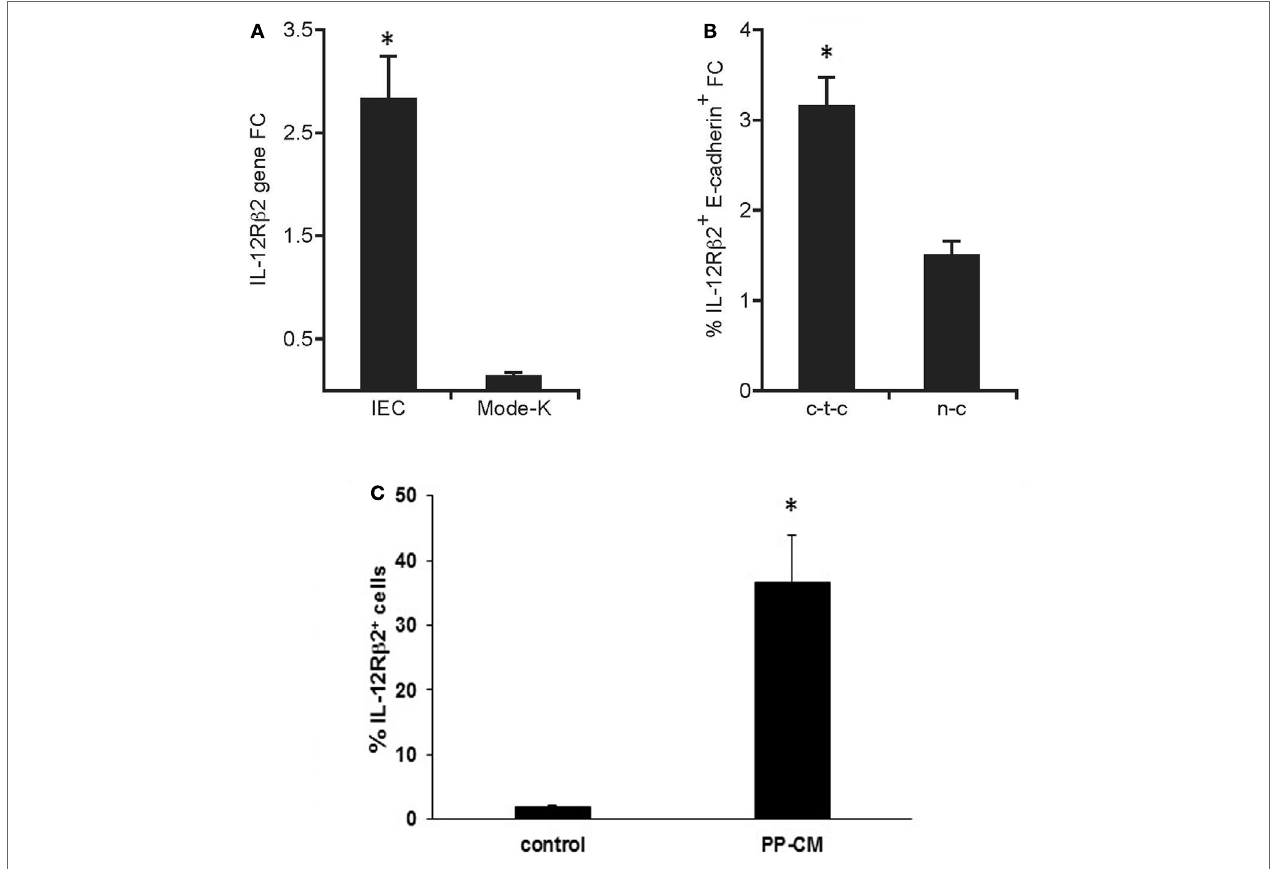
FigUre 3 | Immune system-derived signal(s) are required for the expression of functional IL-12R β 2 on intestinal epithelial cells (IECs). Quantitative RT-PCR analysis showed that the expression of IL-12R β 2 was significantly higher on freshly isolated primary IECs compared to cultured intestinal epithelial cell line MODE-K (a) . By contrast (B) , higher expression of IL-12R β 2 (1.5-fold chance, FC, increase compared IL12R β 2 expression levels in MODE-K untreated control cells) was seen when Peyer’s patch-derived lymphocytes were seeded in the bottom compartment of the Transwells culture system not in contact with MODE-K cells (n-c). However, a more pronounced increase (3.2-fold) was seen when PP-lymphocytes were allowed cell-to-cell interaction with the MODE-K cells (c-t-c). Expression of IL-12R β 2 was also assessed on primary intestinal organoids developed in culture in the absence (control) or in presence of conditioned medium (CM) from 3-day cultures of PP-derived immune cells (PP-CM) chain (c) . A significant increase in the number of organoid cells expressed the IL-12R β 2 was seen when the organoids were grown in the presence of CM. Transcript analysis was carried out in replicate mice (five mice/group) in two independent assays. Data were analyzed using a Student’s t -test (two-tailed, equal variance) followed by application of the Bonferroni correction the level of which was set at p ≤ 0.0125. Mode-K cells were pooled in two independent experiments and samples run in triplicate. Two batches of intestinal organoids/treatment were prepared and samples were run in triplicate. The results are expressed as mean ± SD . (*) indicates statistical difference. p <